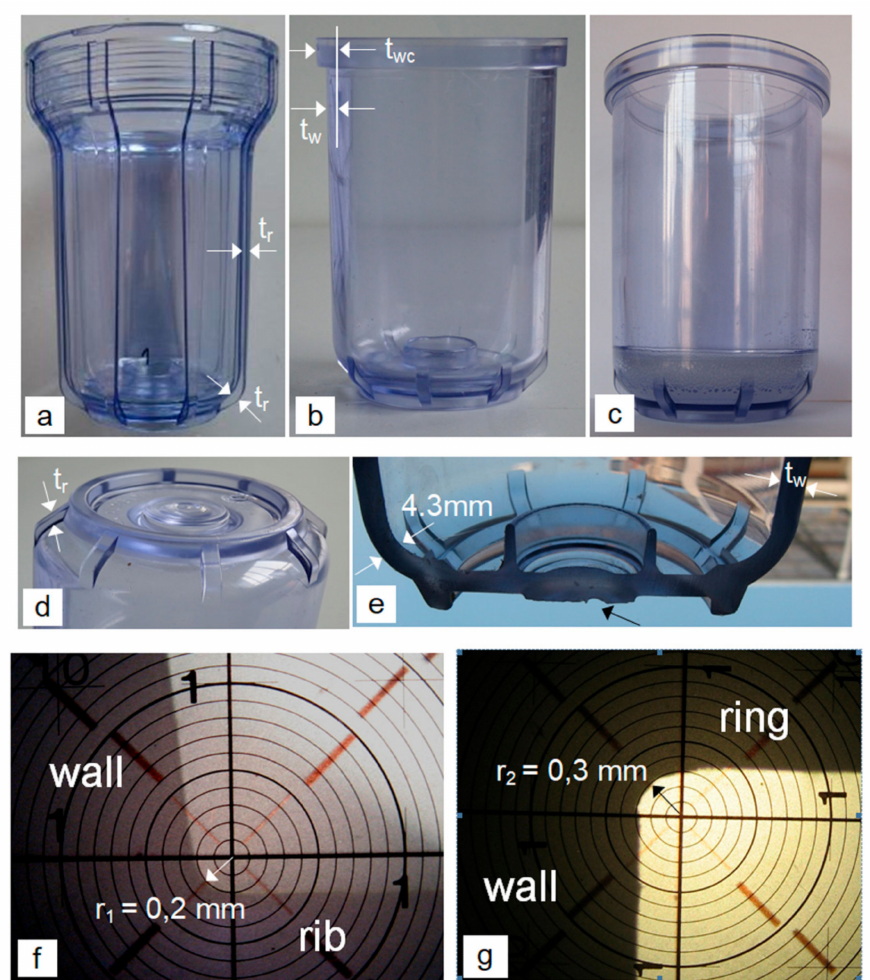
Figure 1. Types of water-filter housings and some of their geometric characteristics ( a ) housing with the external vertical ribs [1] ( b ) housing without the vertical ribs ( c ) housing without the vertical ribs with an increased base thickness ( d ) the base of the housing without the vertical ribs ( e ) the cross-section of the base between the ribs ( f ) the transition radius r 1 between the ribs and the wall ( g ) the transition radius r 2 between the clamp ring and the